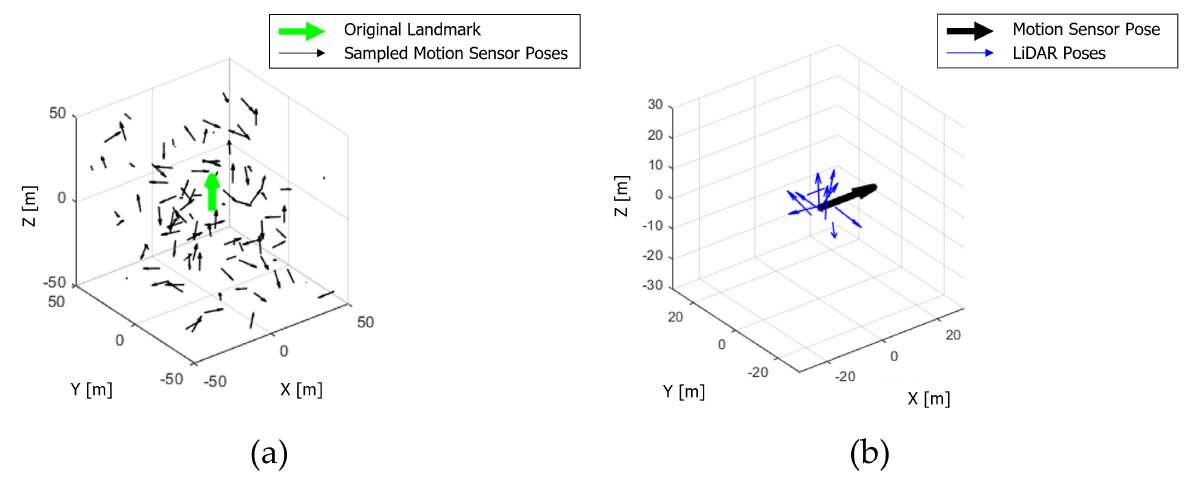
Figure 6. ( a ) Landmark for detection (green) and 100 sampled motion sensor’s poses (black). ( b ) 10 sampled LiDAR poses (blue) based on one motion sensor’s pose (black).